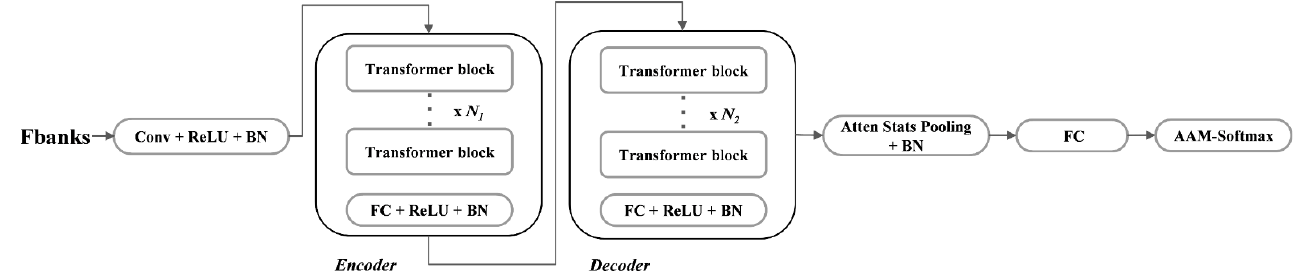
Figure 1. The overall architecture of the proposed Transformer.